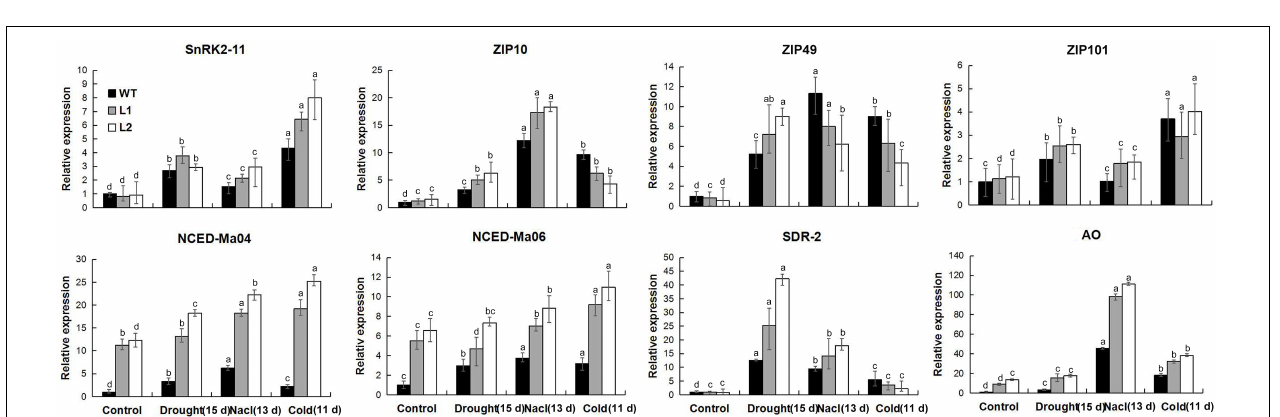
FIGURE 8 | Comparisons of physiological indices between WT and transgenic plants under normal, cold, and recovery conditions. Control means banana seedlings (100-day-old) grow normally. Cold means banana seedlings (100-day-old) were subjected to cold treatment (8 ◦ C) for 5 days, and recovery means banana seedlings (100-day-old) growth recovery for 11 days following 5-day cold treatment. The leaves were then sampled to perform physiological analyses. Data are means ± SD of n = 3 biological replicates. Means denoted by the same letter are not significantly different at P < 0.05 as determined by Duncan’s multiple-range test.